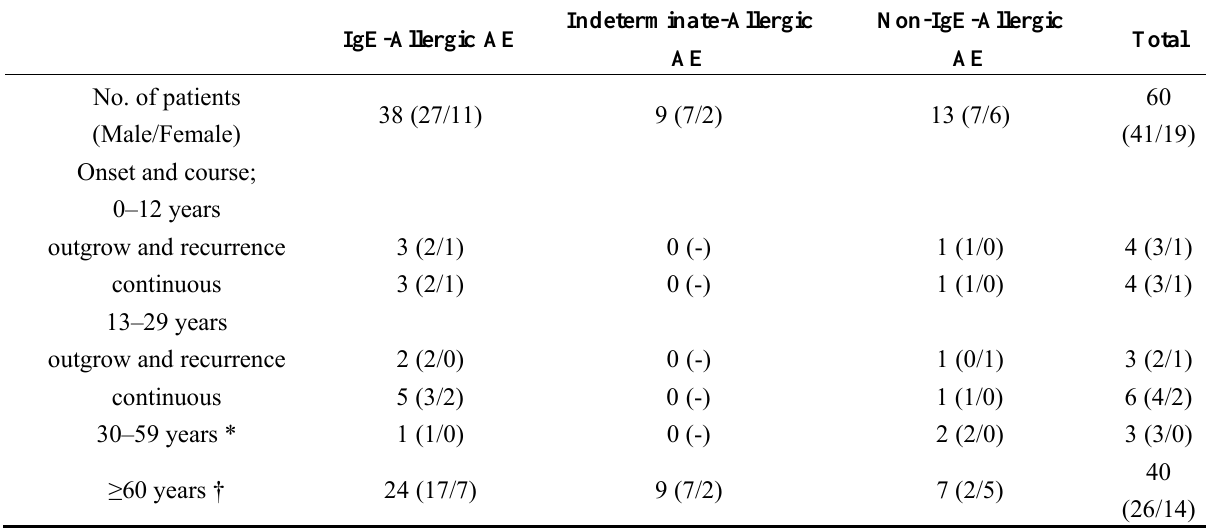
Figure 1. Age at onset of atopic eczema in elderly patients. Table 2. Age at onset and clinical course in elderly patients with atopic eczema